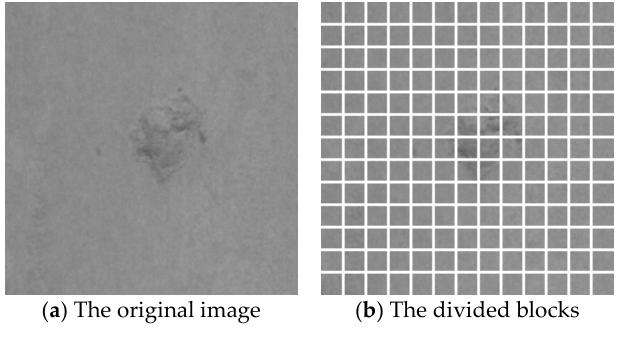
Figure 10. Divide original image into blocks.